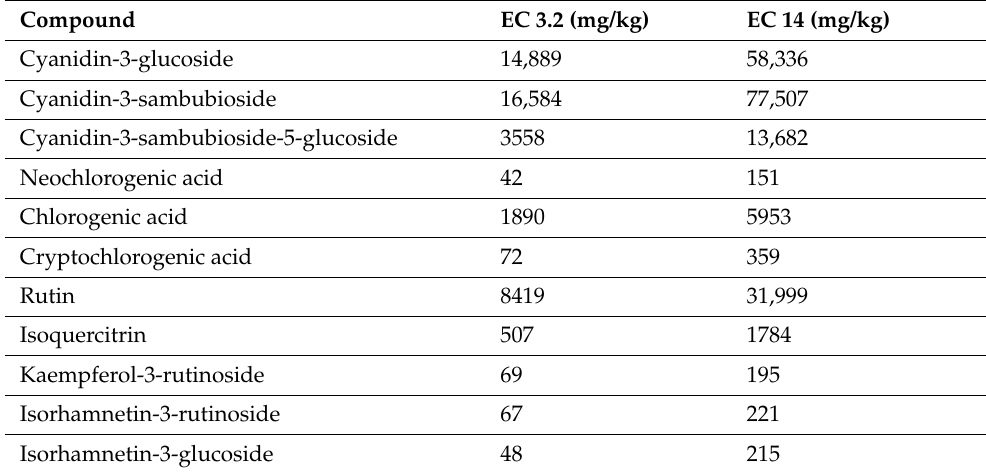
Table 1 summarizes the total amounts of the identified compounds of EC 3.2 and EC 14. Table 1. Quantitative analysis of compounds in black elderberry extracts EC 3.2 and EC 14.